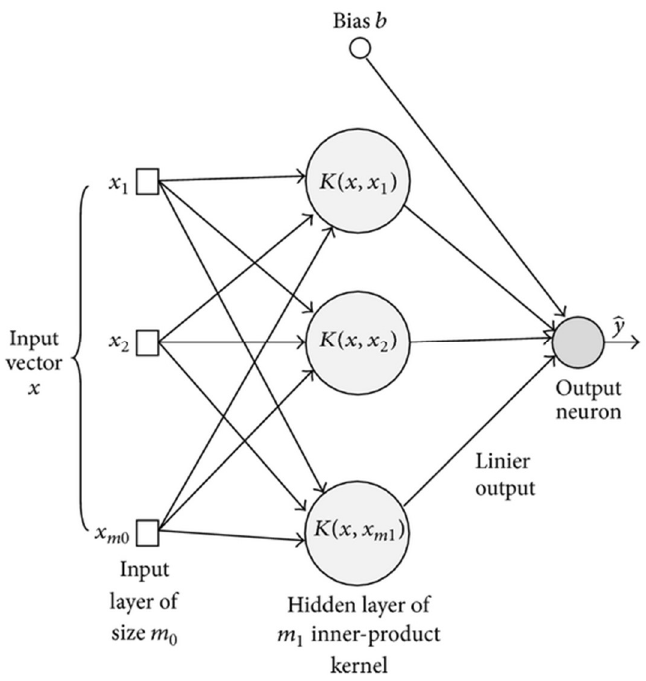
Figure 17. Our SVM architecture. The input Vector our context is filled by the features extracted at the feature layer of our Inception V3.